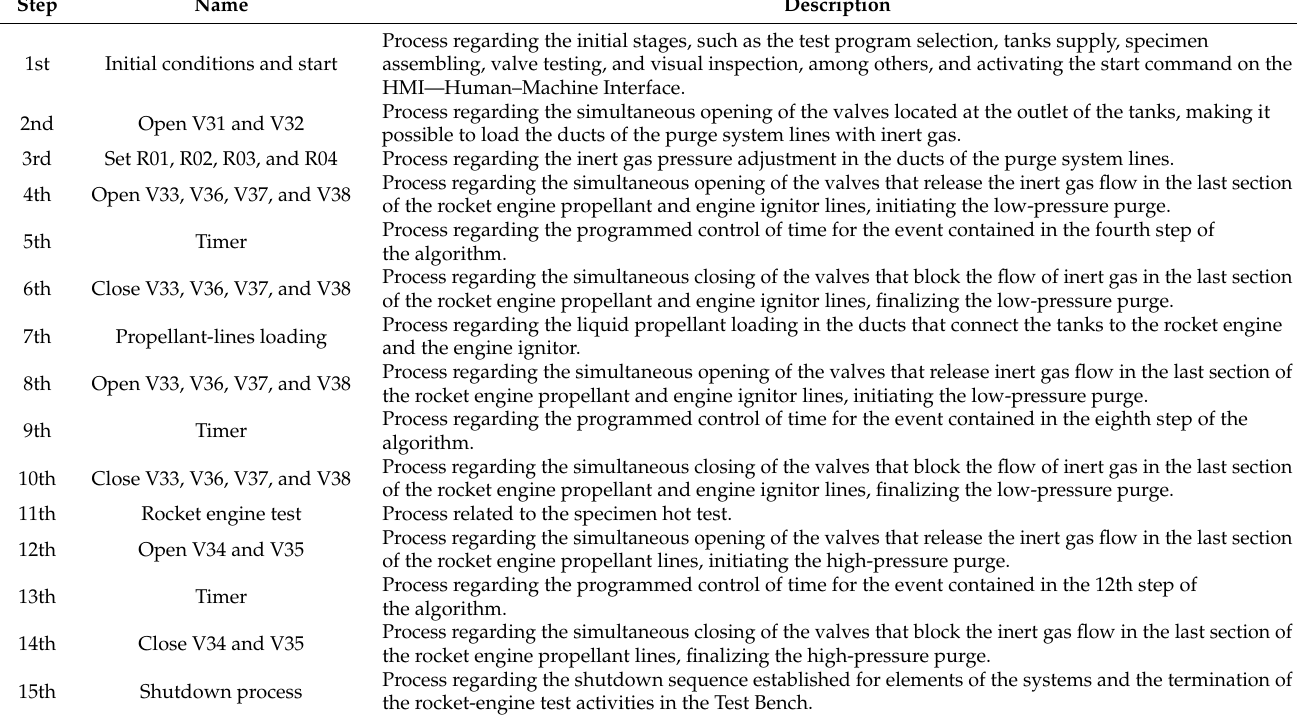
Table 2. Description algorithm blocks.